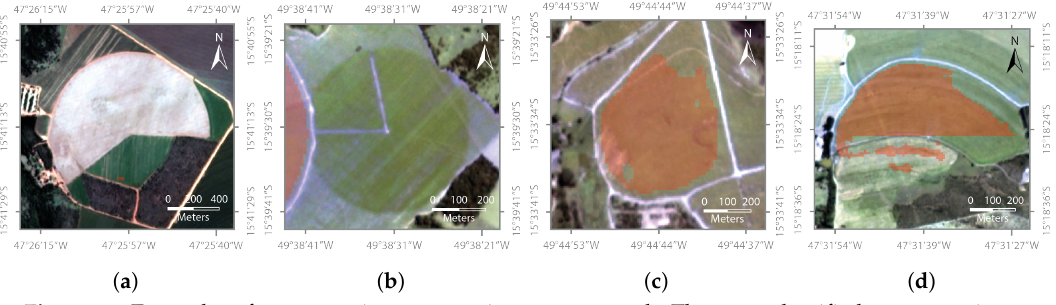
Figure 10. Examples of segmentation errors using our approach. The areas classified as center pivots are shown in red. ( a ) Omission error likely caused by irregular shape; ( b ) Omission error caused by faint borders; ( c , d ) Inclusion error caused by curved